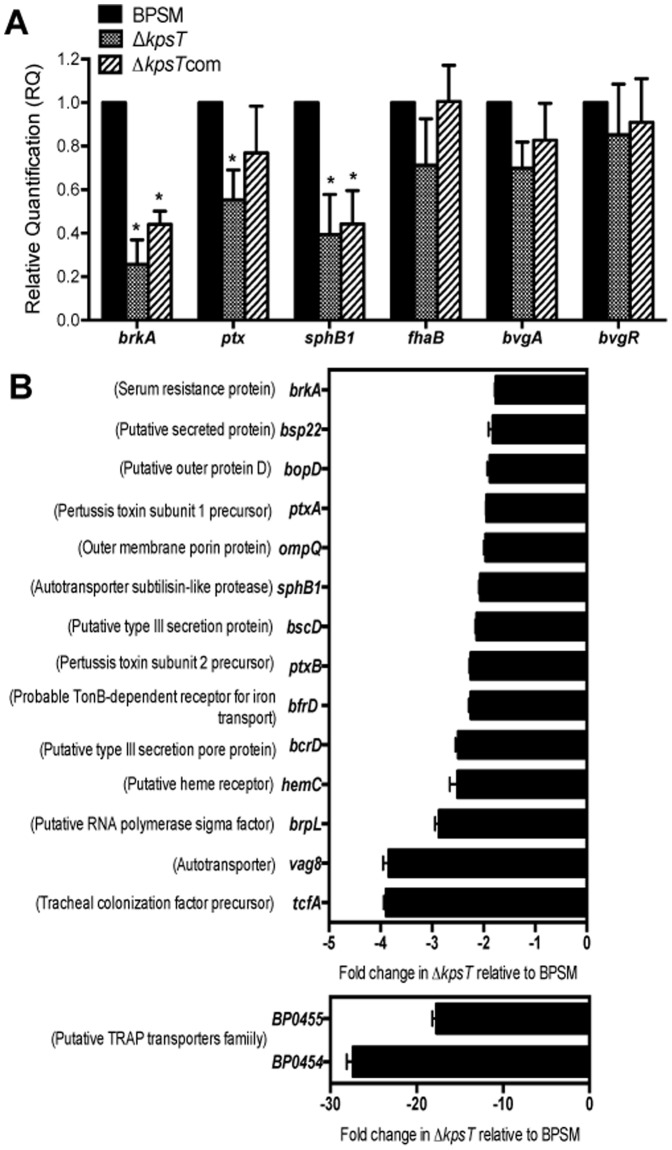
Trancriptional activity in ΔkpsT mutant.(A) Relative transcriptional activity of
vags
. Total RNA was extracted from BPSM (solid bars), ΔkpsT (dotted bars) and ΔkpsTcom (stripped bars) strains grown in virulent Bvg+ phase. Real-time PCR analysis was performed using primers mapping in the brkA, ptx, sphB1, fhaB, bvgA and bvgR genes. recA gene was used as the endogenous control. Results are expressed as average relative quantification (RQ) vs wild type BPSM (RQ = 1). Results are representative of 3 independent experiments. (B) Microarray analysis. Total RNA was extracted from BPSM and ΔkpsT strains grown in virulent (Bvg+) phase. Microarray gene expression values were selected based on log2 fold change <-0.8, with adjusted p value<0.01. Results are expressed as average fold change ΔkpsT compared to BPSM, negative value indicates gene repression. Solid bars represent standard deviation of 2 independent experiments.